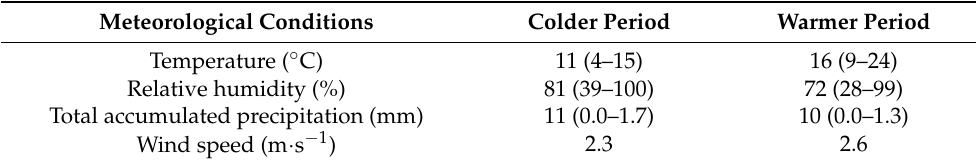
Table 2. Coimbra meteorological conditions during the sampling period. The range and the mean values are presented for temperature, relative humidity, total accumulated precipitation and wind